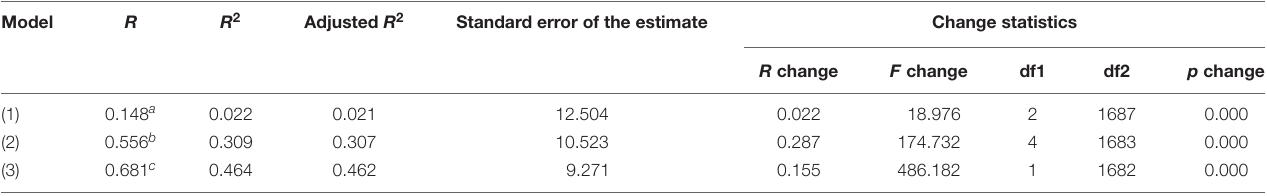
TABLE 4 | Stepwise model summary between empathy and the single factor with marked discrepancy. Model R R 2 Adjusted R 2 Standard error of the estimate Change statistics